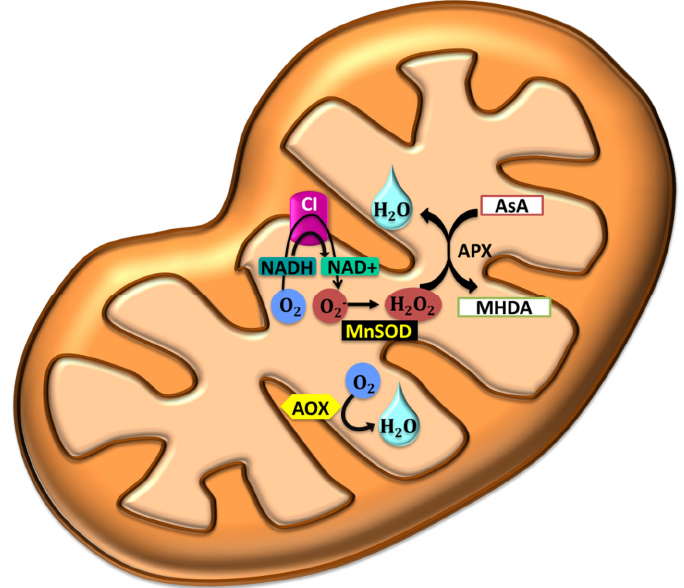
Figure 2. The process of redox in the mitochondria. Any form of stress causes alleviation in ROS due to ATP synthesis, leading to a reduction in the ubiquinone pool (UQ) pool. Several enzymes work together to manage ROS levels in mitochondria.